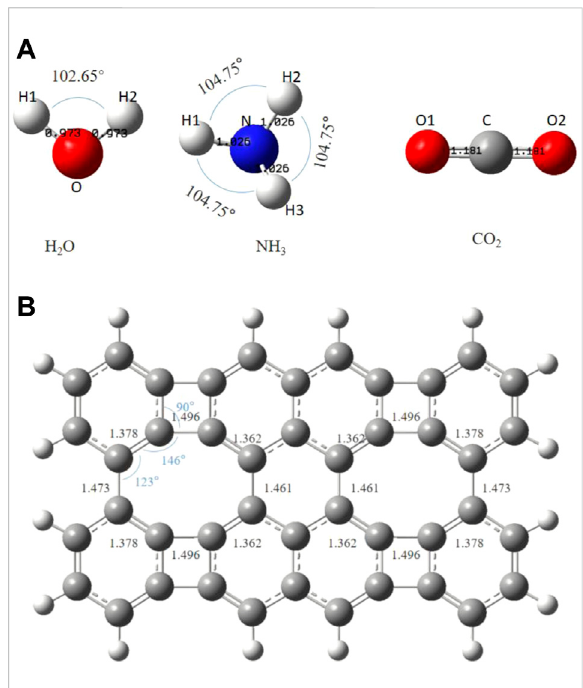
FIGURE 2 The optimized Structures of (A) H 2 O, NH 3 , CO 2 and (B) the graphene-like surface. The bond lengths are in